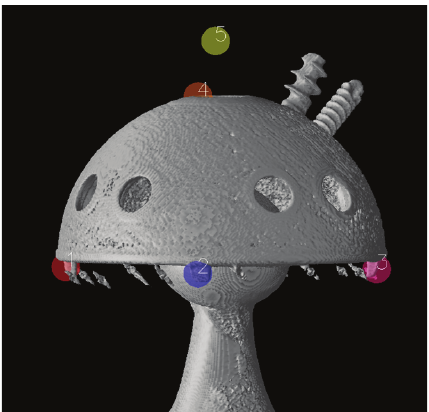
Figure 2: The five landmarks chosen on the acetabular cup are shown in 3D. Only landmarks 1, 2, 3, and 5 are used in the surface extractor calculations. Landmark 4 is used only by the operator to locate the apical dome